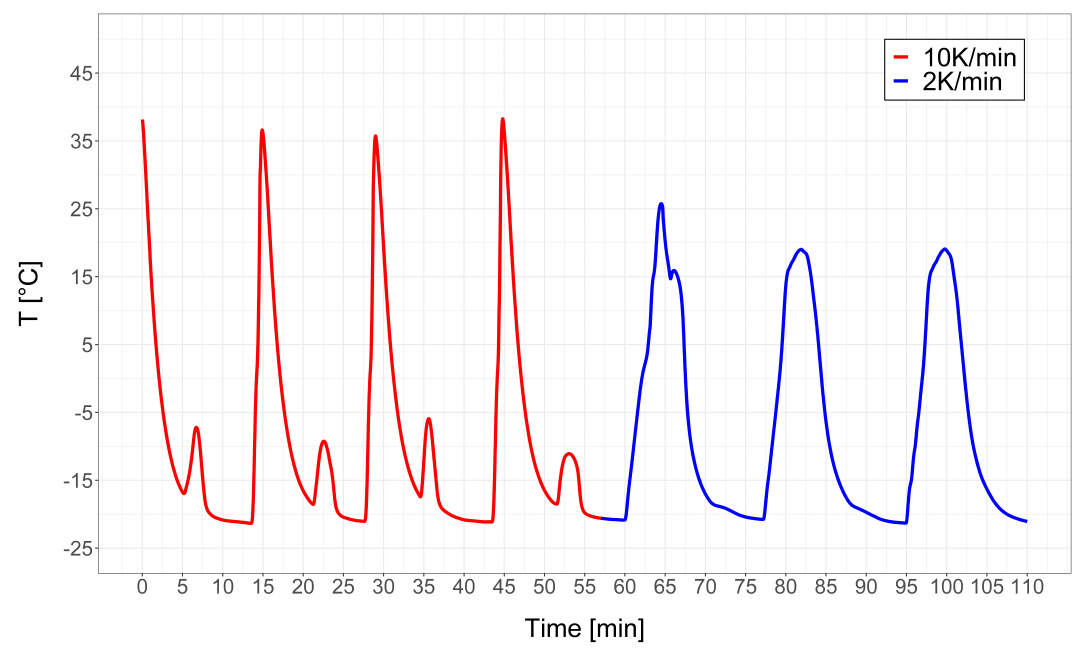
Figure A4. Example of BEB’s thermal cycling in METTLER TOLEDO’s EasyMax